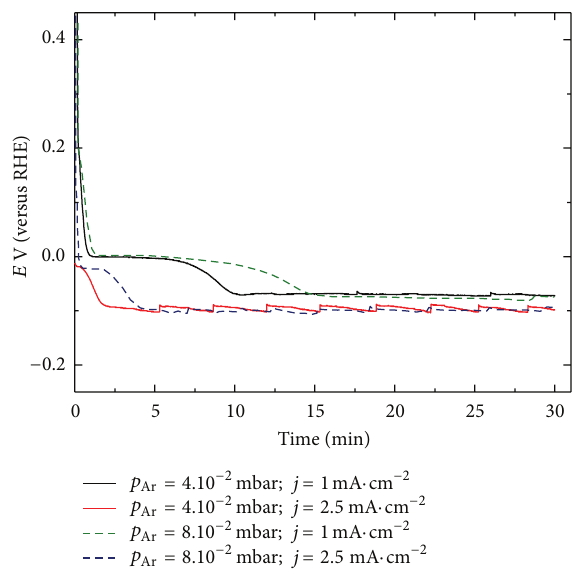
Figure 6: Electrochemical hydrogenation of 500 nm thick Pd layers deposited at sputtering pressure of 4 ⋅ 10 −2 mbar (solid line) and 8 ⋅ 10 −2 (dash line) at different charging currents.